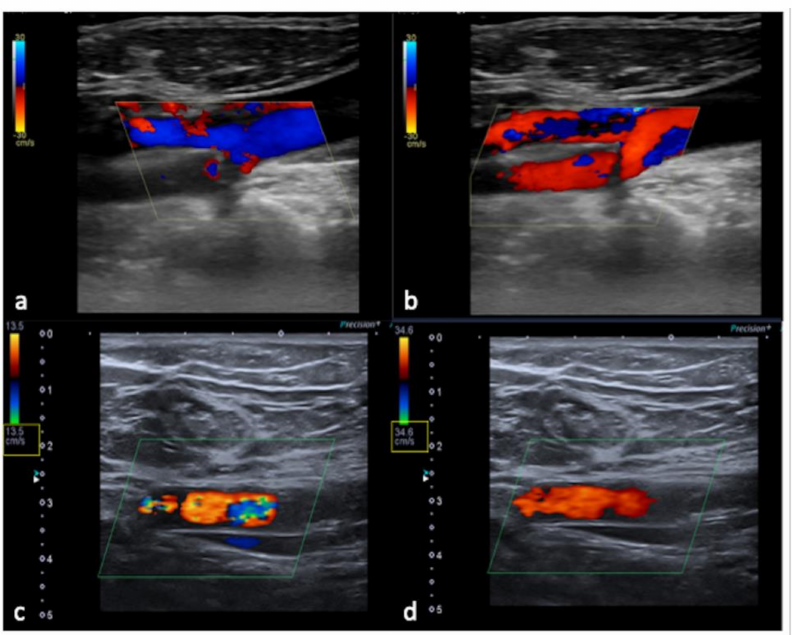
Figure 14. Flow sampling error with anomalous steering ( a ) misinterpreted as occlusion of the internal carotid artery; after steering correction ( b ) a normal artery patency is evident. False aliasing ( c ) and its correct setting ( d ) by changing the detection parameters upwards of the flow rate (yellow box, c , d ).